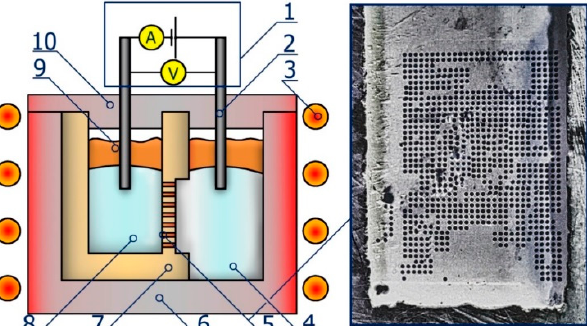
Figure 2. Schematic representation of a multiple-capillary cell: 1—PGSTAT Autolab 302n with